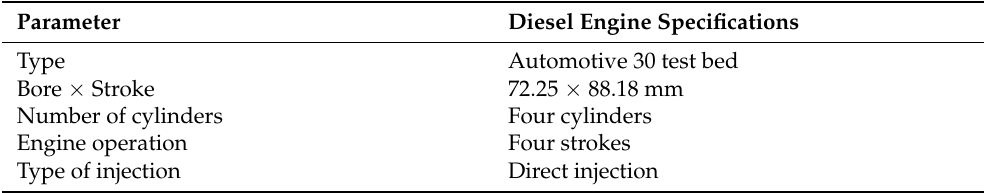
Table 1. Technical data of automotive 30 test bed diesel